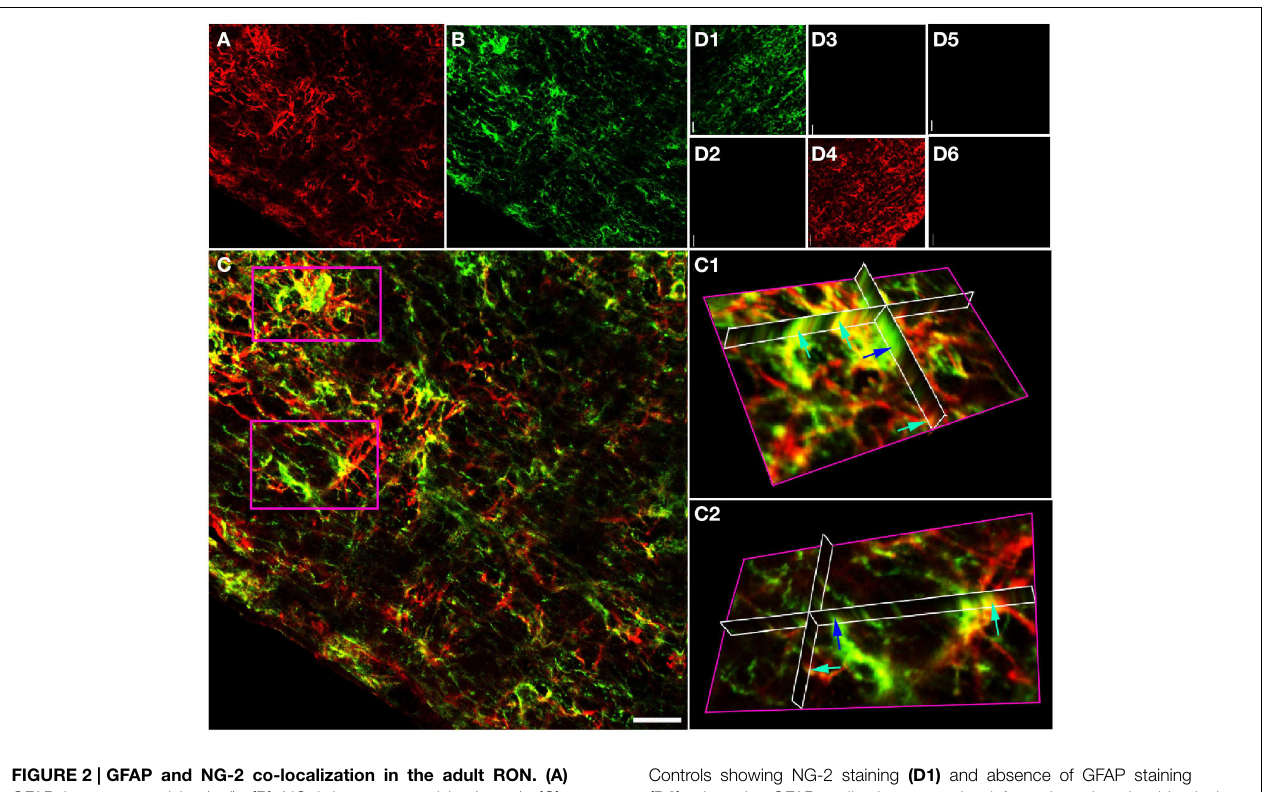
FIGURE 2 | GFAP and NG-2 co-localization in the adult RON. (A) GFAP immuno-reactivity (red). (B) NG-2 immuno-reactivity (green). (C) Overlay with boxed areas shown at higher gain as 3-D projections in (C1) and (C2) . Note the NG-2 co-localization (red or orange, e.g., light blue arrows) in parts of cells that may express GFAP alone in other regions, and in cells that are only GFAP( + ) (e.g., dark blue arrow). (D)